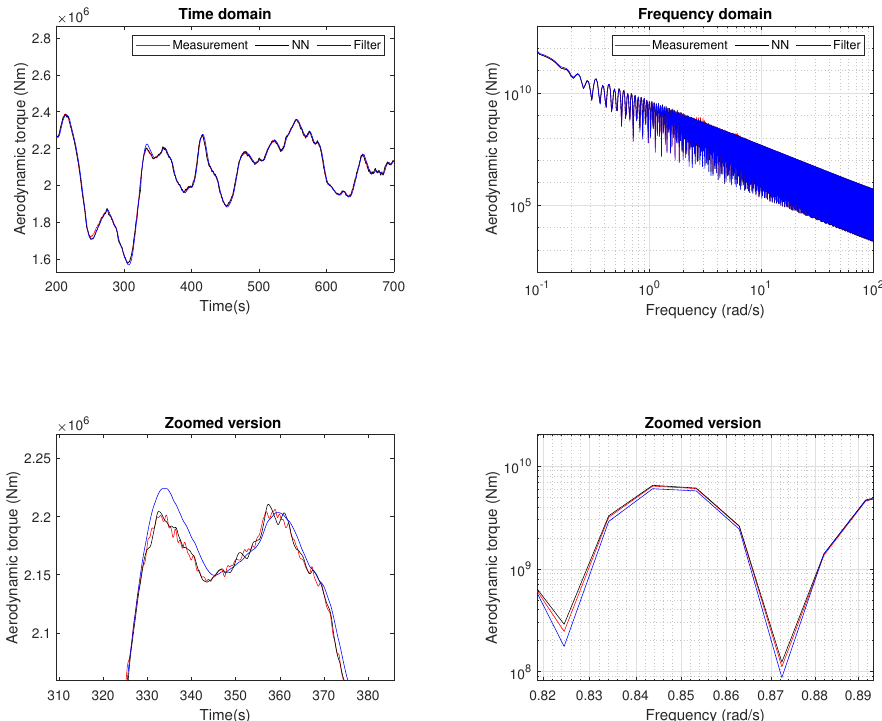
Figure 9. Scenario 2: Aerodynamic torque estimation from Turbine 5.